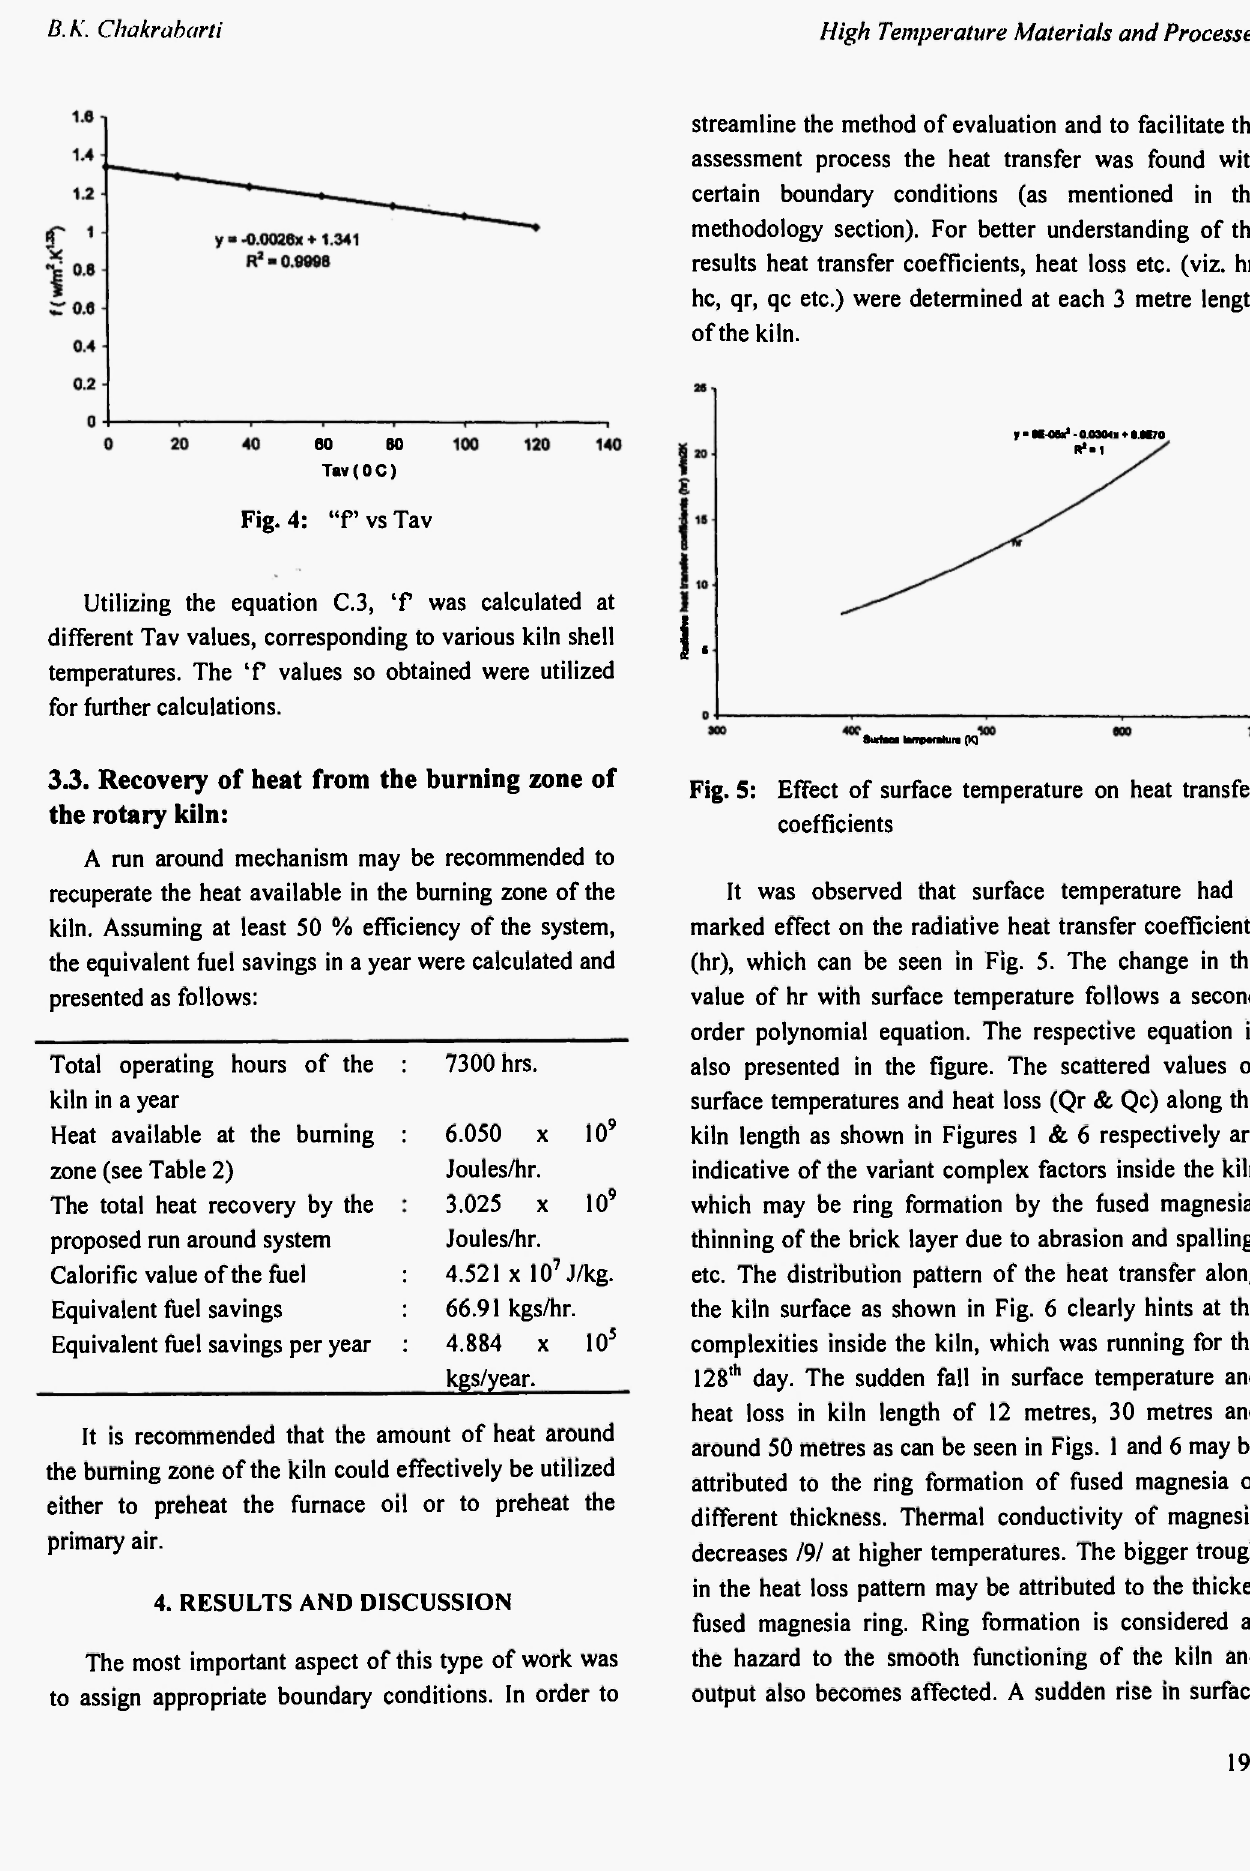
Fig. 5: Effect of surface temperature on heat transfer